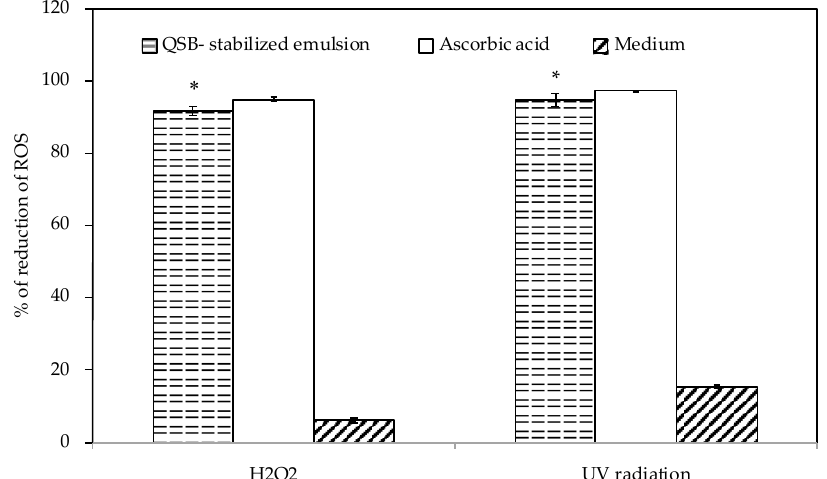
Figure 6. ROS (Reactive Oxygen Species) reduction after exposure to H 2 O 2 of HaCaT cells and UV-B radiation, containing QSB-stabilized emulsion and ascorbic acid. The data are expressed as the mean of at least 12 replicate experiments ± standard deviation. Significance: (*) p < 0.05 versus positive control cells (ascorbic acid).